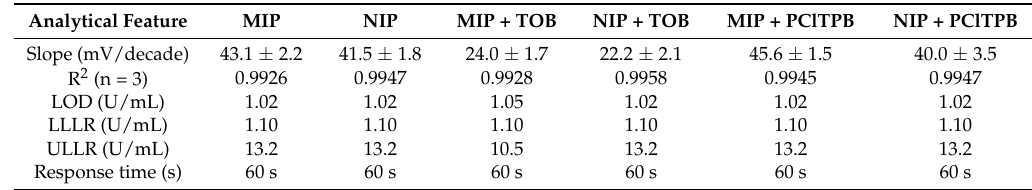
Table 4. Main analytical features of the ISEs in the presence of interfering specie IL-6 under the specified concentrations, in pH